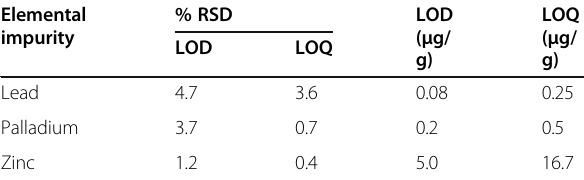
Table 6 Summery of LOD and LOQ experiments